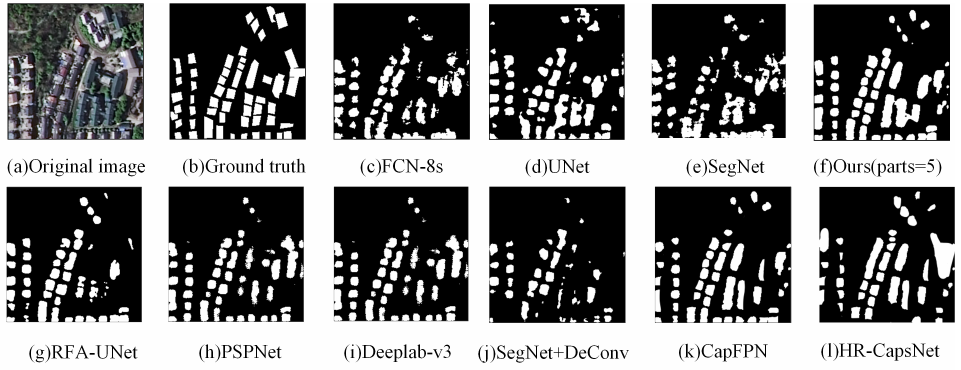
Figure 5. Comparison of different building extraction methods on source dataset. ( a ) is the original im- age, ( b ) is the ground truth, ( f , k , l ) are capsule-based methods, and the rest are CNN-based